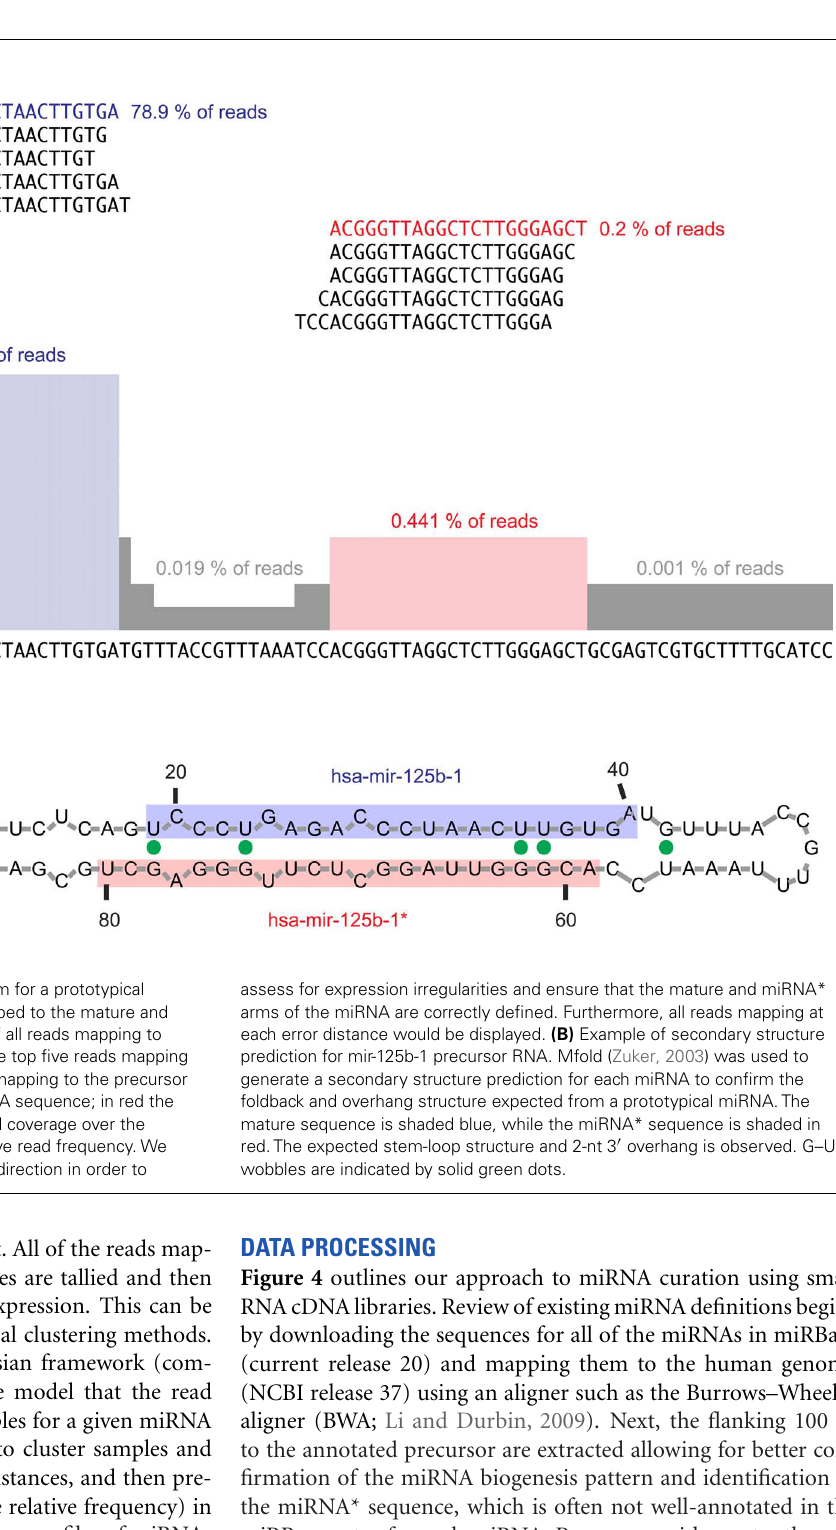
FIGURE 3 | (A) Example of read alignment diagram for a prototypical miRNA. Displayed are the top five reads that mapped to the mature and miRNA* sequences, respectively. About 99.4% of all reads mapping to the precursor mapped to the mature arm while the top five reads mapping to the miRNA* arm only captured 0.4% of reads mapping to the precursor sequence. Highlighted in blue is the mature miRNA sequence; in red the miRNA* sequence.The histogram shows the read coverage over the precursor sequence, represented as log4 of relative read frequency.We suggest expanding the sequence 100 nt in either direction in order to